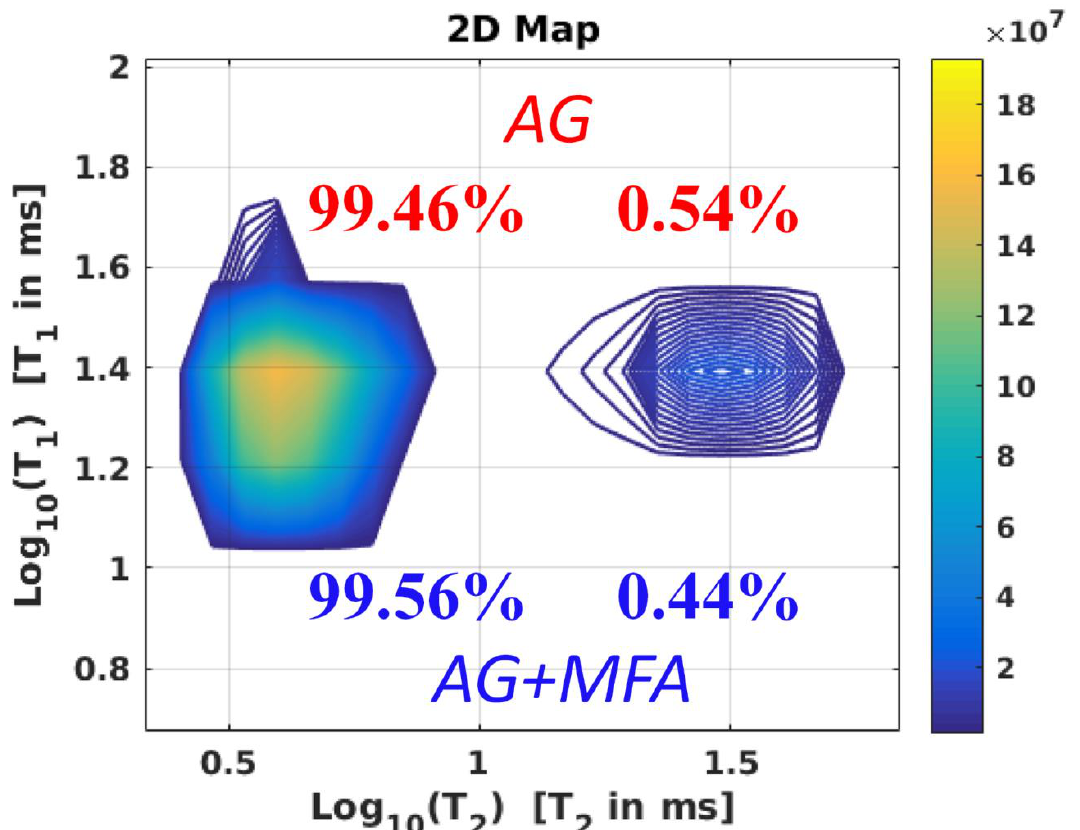
Figure 5. Two-dimensional maps of RRCOSY correlations of carbon dioxide in the original aerogel (red) and the aerogel-doped system (blue) are shown. The logarithms of the relaxation times T 1 and T 2 are represented by the ordinate and abscissa, respectively. The maps illustrate a marked disparity in integral intensities between the two systems.